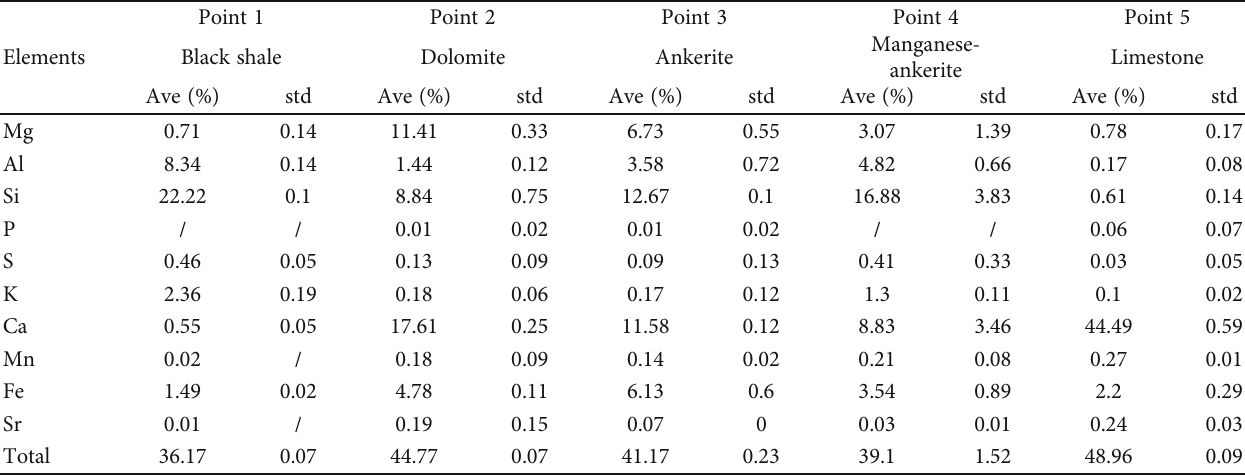
Table 1: Normalized atomic weight percentages of points 1-5 in Figure 1(d). The total percentages lower than 100% were due to the removal of other elements. Slashes of some elements mean their contents are below the detection limits.